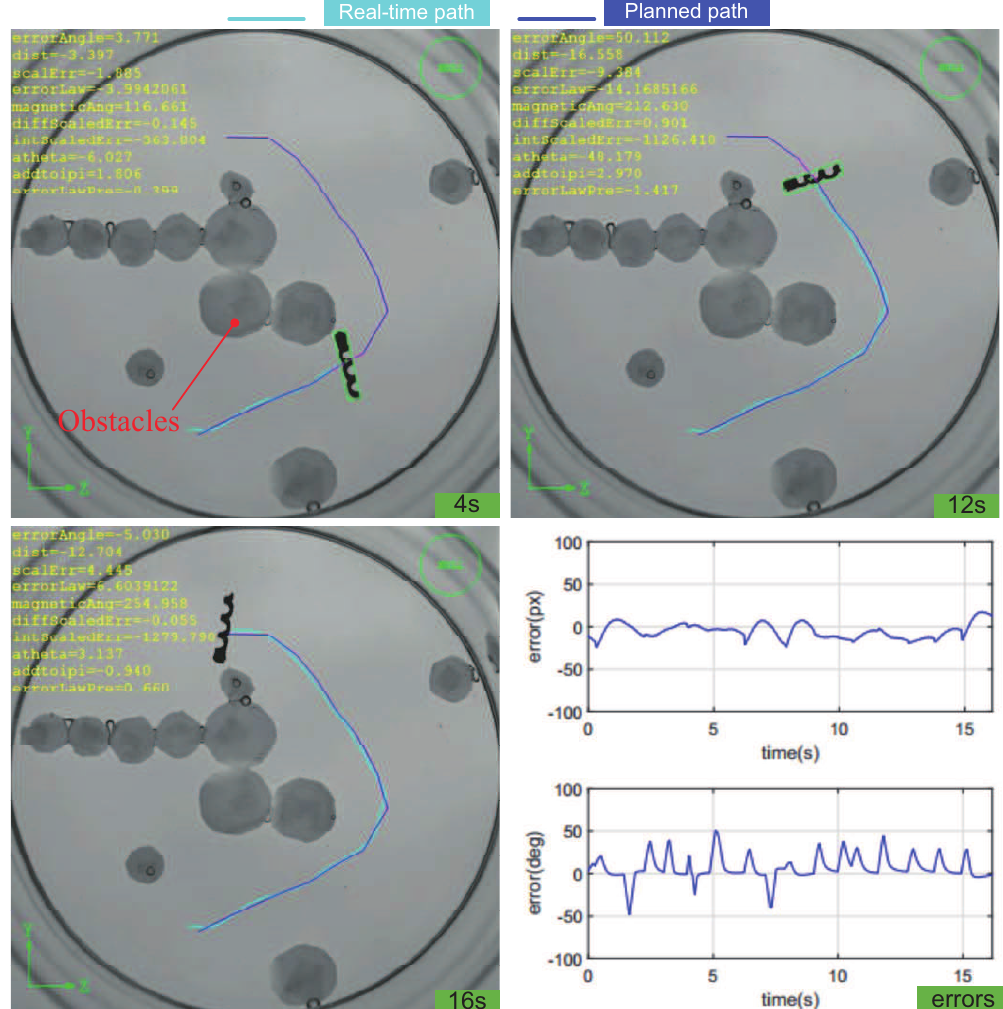
Figure 12. Control of the helical microswimmer on the planned path at different